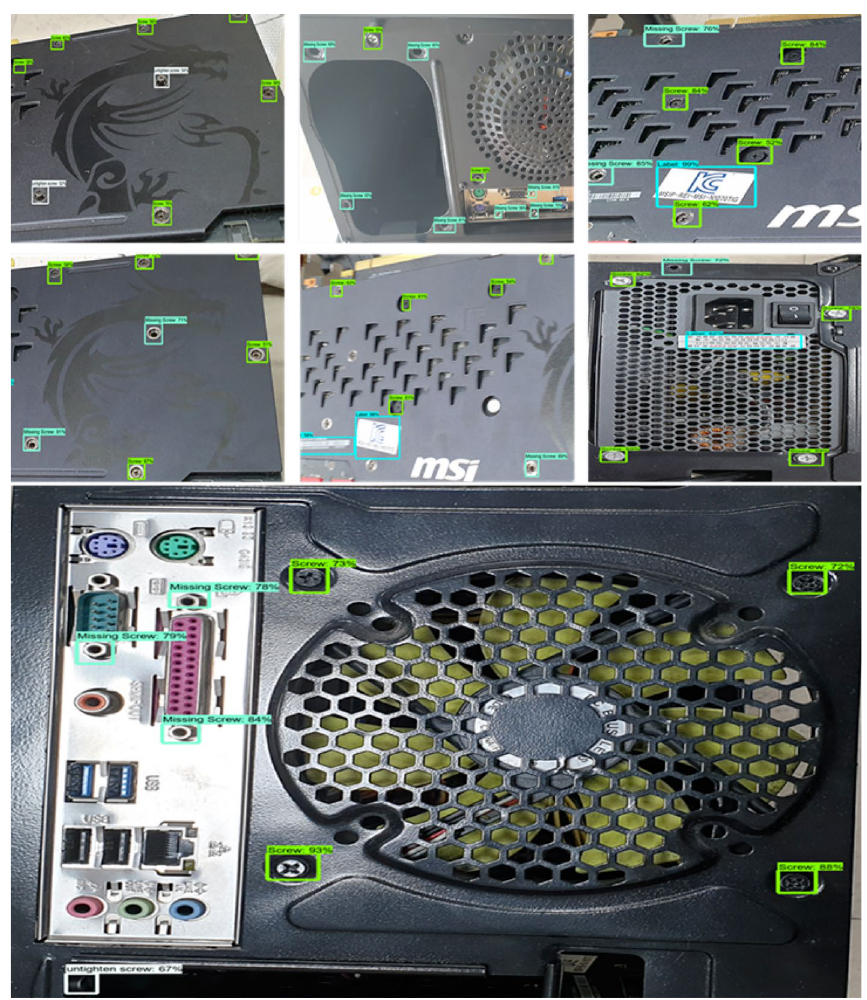
Figure 8. Real-time environmental testing. Model tested on product images, where our four object classes exist, i.e., screws, labels, missing screws, and untight